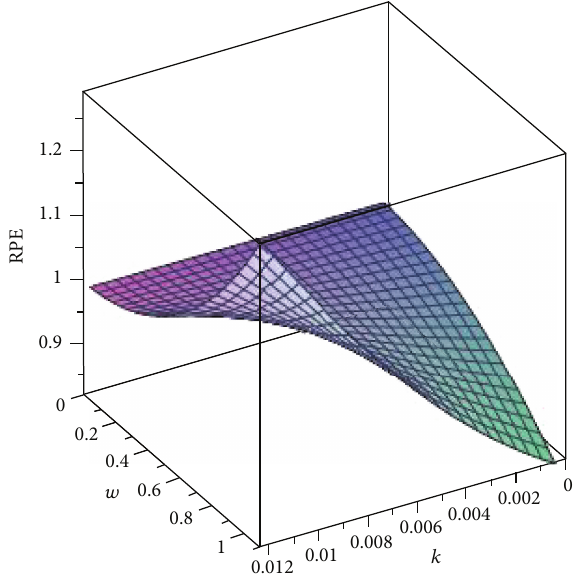
Figure 8: Plot of RPE versus 𝑘 versus 𝑤 for the Lax-Wendroff scheme at ℎ = 0.02